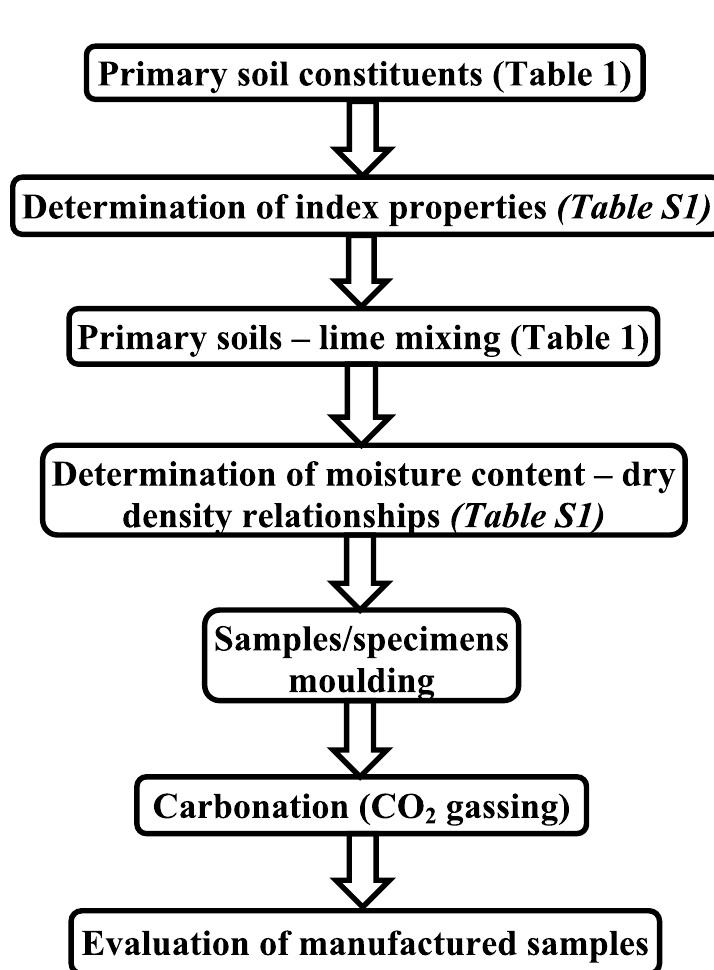
Fig. 2 Summary of samples production